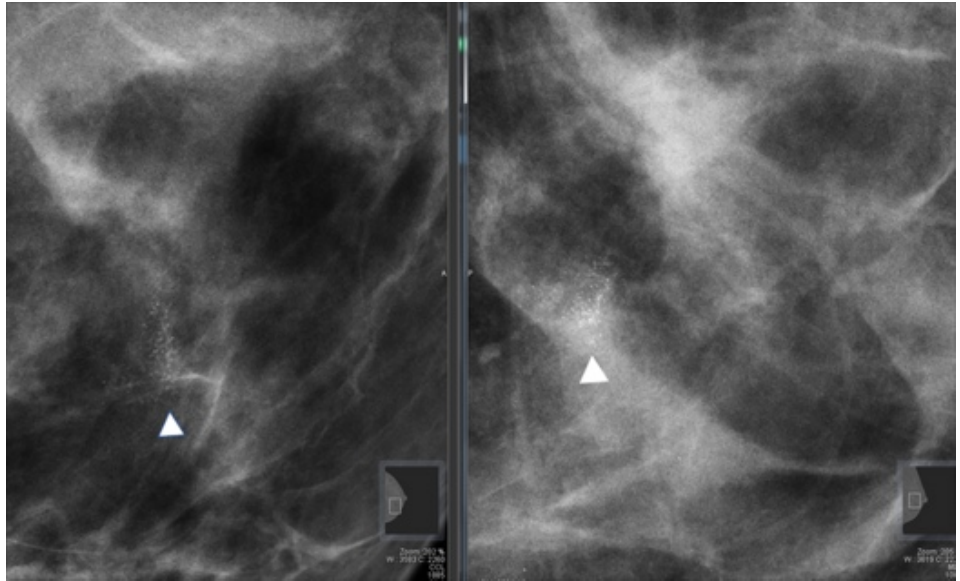
Figure 2. Full field digital mammography showing a cluster of microcalcifications (arrowhead) with a biopsy-proven histopathological result of atypical ductal